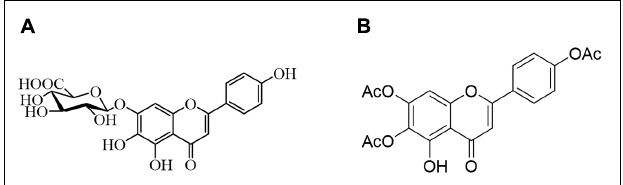
FIGURE 1 | (B) Chemical structure of 6,7,4 (cid:48) -O-triacetylscutellarein (TA) and (A) scutellarin